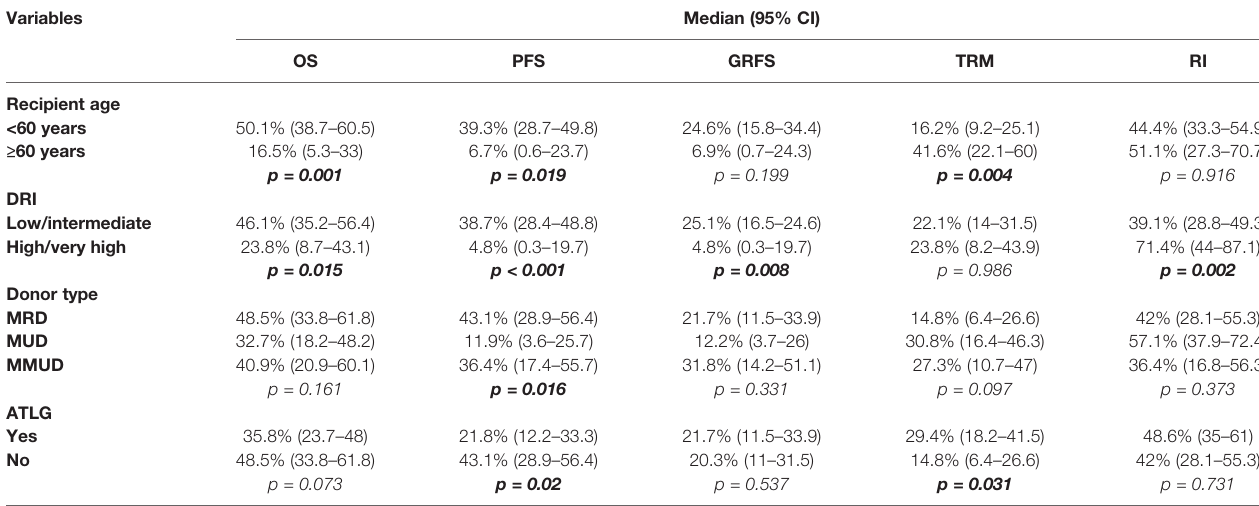
TABLE 2 | Univariate analysis for signi fi cant transplant outcomes at 12